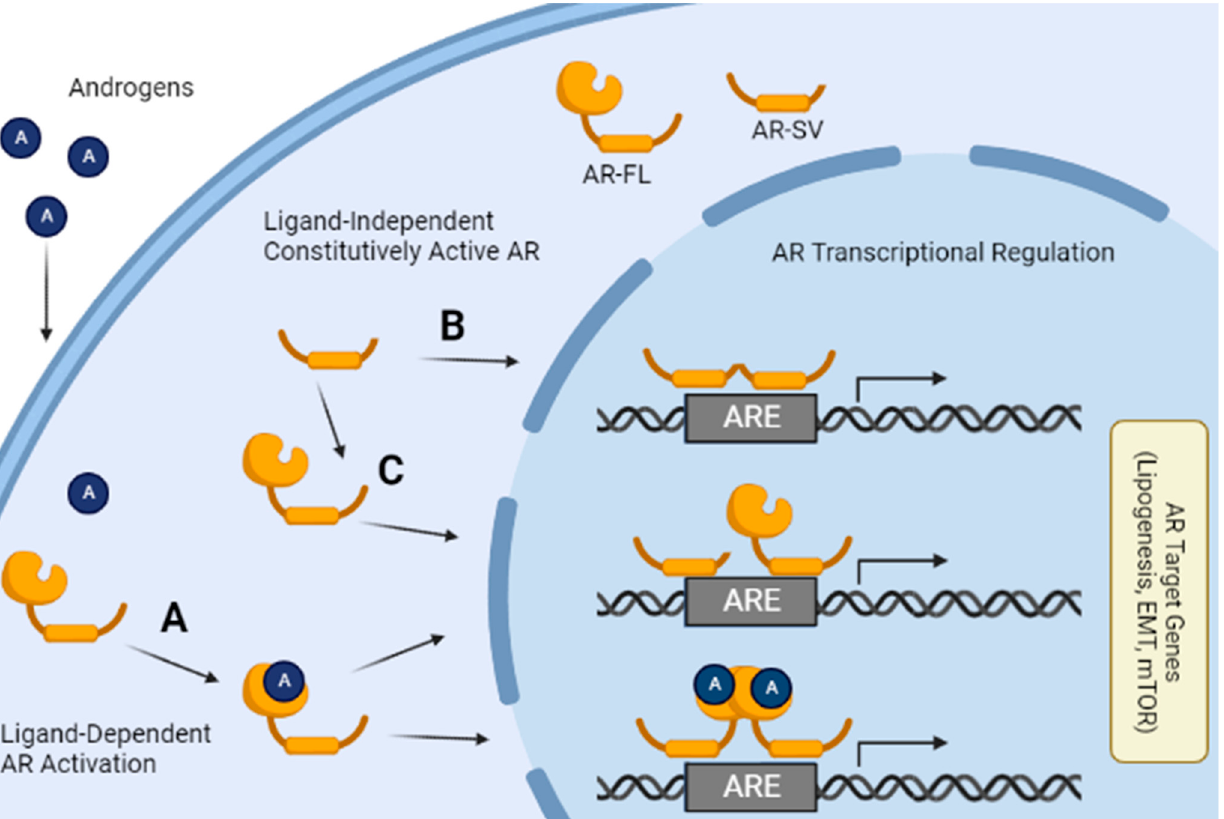
Figure 4. Illustration of mechanisms of ligand-independent and ligand-dependent AR-mediated transcriptional regulation. (A) Androgens bind to the LBD of AR-FL leading to nuclear localization, dimerization, and binding of the DBD to androgen response elements (AREs) in the DNA. (B) In the absence of androgens AR-SVs both dimerize and localize to the nucleus. (C) In the absence of androgens, AR-SVs are also able to facilitate AR-FL nuclear localization without androgen binding to the LBD. These various methods of AR activation ultimately result in the regulation of AR target genes and more broadly gene pathways such as lipogenesis, EMT, and mTOR-related pathways. Figure created in